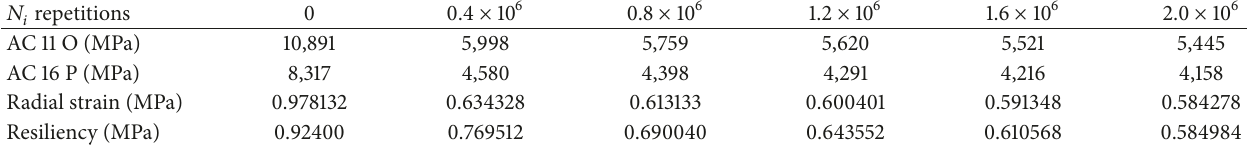
Table 3: Elastic modulus, radial strain, and resiliency decrease in relation to traffic loading.